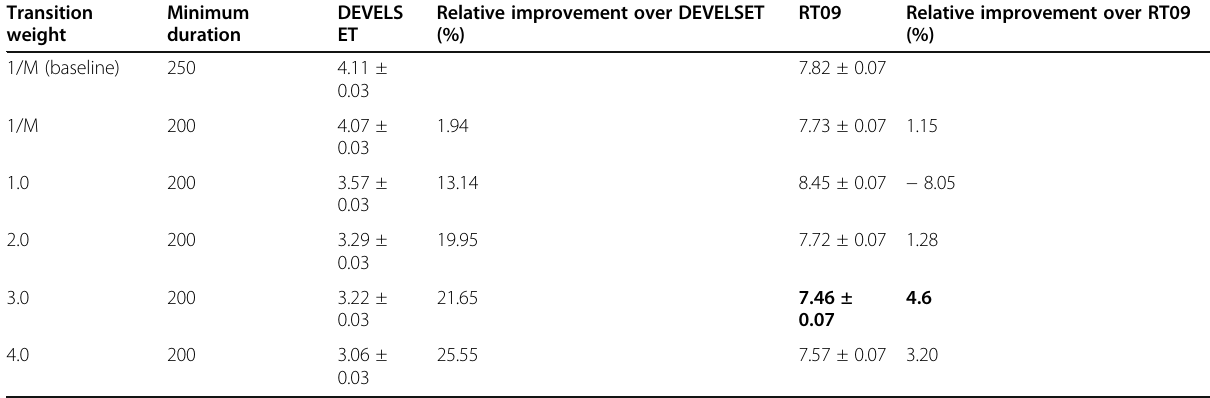
Table 2 SER for all the systems developed, confidence intervals are also included. M is the number of active clusters at each iteration. Weight applied to MFCCs is 0.85 and weight applied to TDOA is